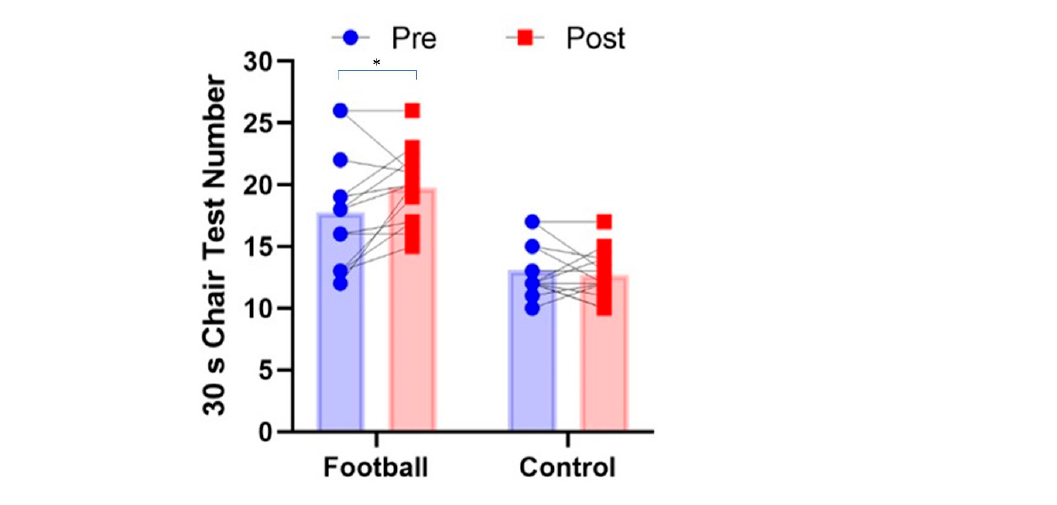
Figure 2. Group mean and individual performance for 30 s chair stand performance (number of repetitions) before and after in recreational football for health intervention group and matched (* p < 0.05).